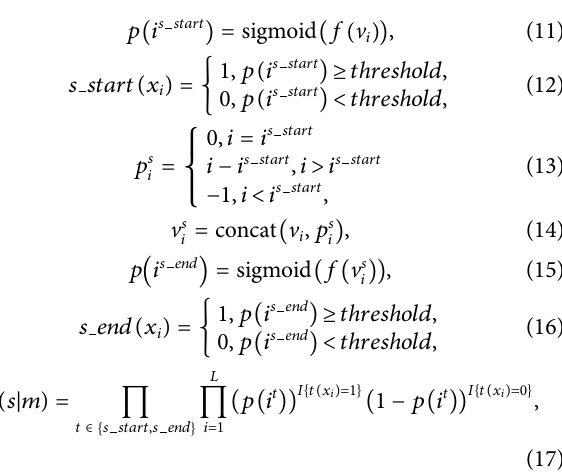
FIGURE 3 | Residual dilated gated convolution